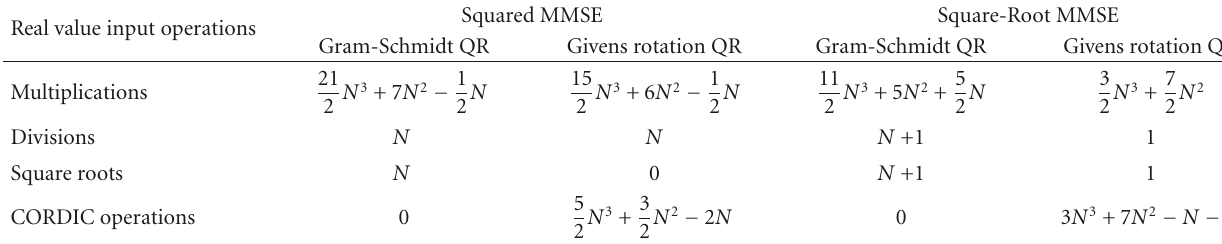
Table 2: Operation counts for computing W MMSE and